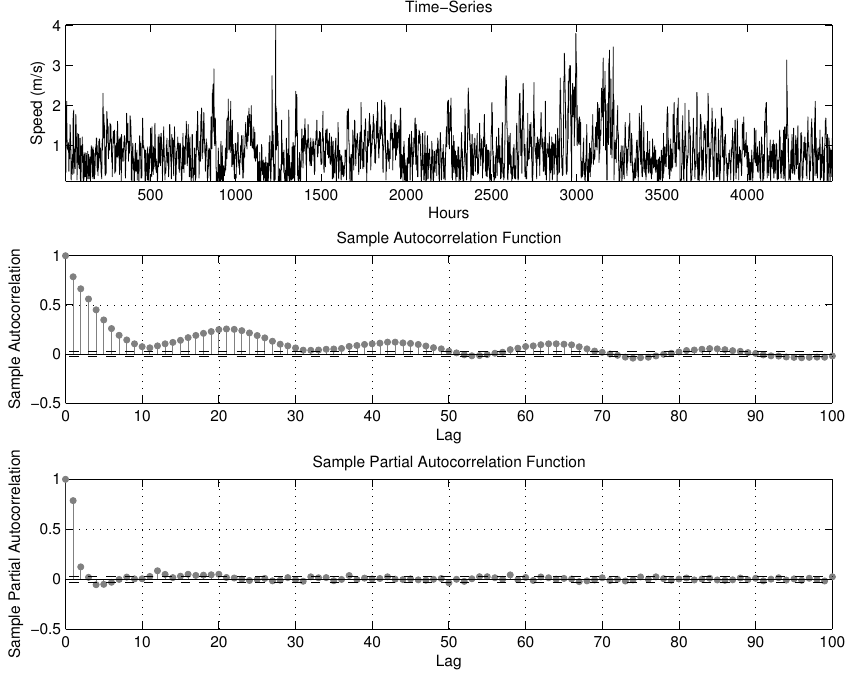
Time series wind speed, autocorrelation function (ACF) and partial autocorrelation function (PACF) plots at Pe ˜